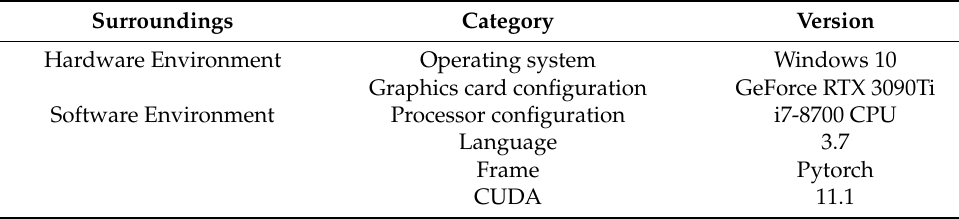
Table 6. Hardware and software environment required for model